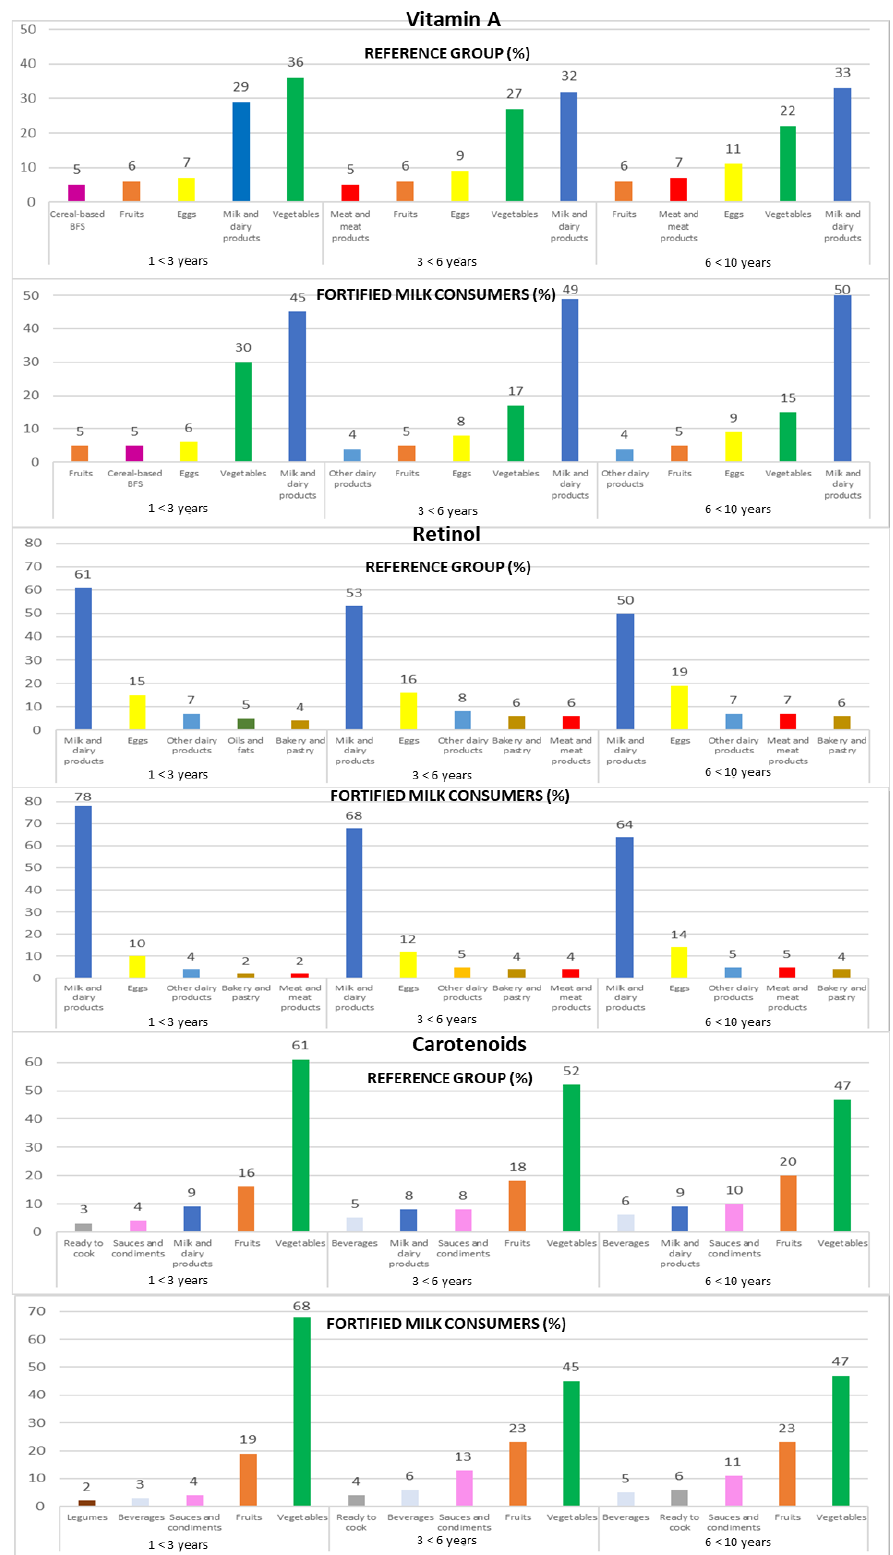
Figure 2. Contribution of the main five food groups (in percentages) to total vitamin A, retinol, and carotenoids intakes in the EsNuPI study subpopulations according to age group: 1 to <3 years, 3 to <6 years, and 6 to <10 years. Cereal-based baby food and supplements (cereal-based BFS).